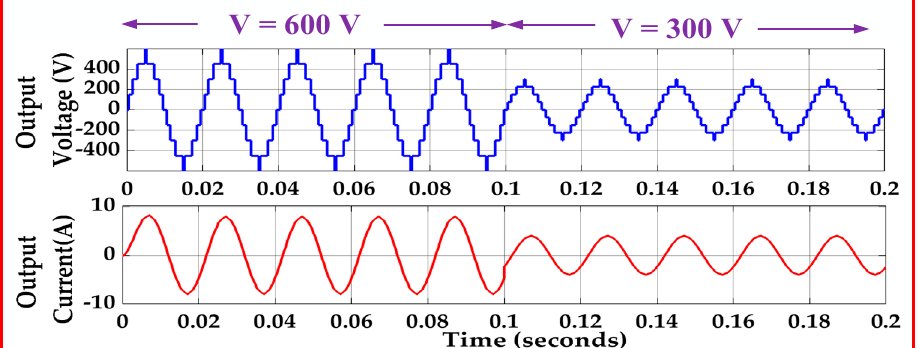
Figure 13. Modulation index (m) variation. The THD for the nine-level inverter was compared using the genetic algorithm (GA), differential evolution (DE), and the reptile search algorithm (RSA), as shown in Figure 14. The graphs depict THD fluctuation as a function of the modulation index, which ranges from zero to one. THD is lower for RSA with an m of 0.35 in the case of the nine − level inverter. Between 0.4 and 0.6, DE has a superior result. From 0.6 to 0.65, GA performs best, whereas DE performs best from 0.64 to 0.7. The THD is almost the same for all techniques, with m > 0.69. Table 2 lists the parameter values used in the GA, DE, and RSA.